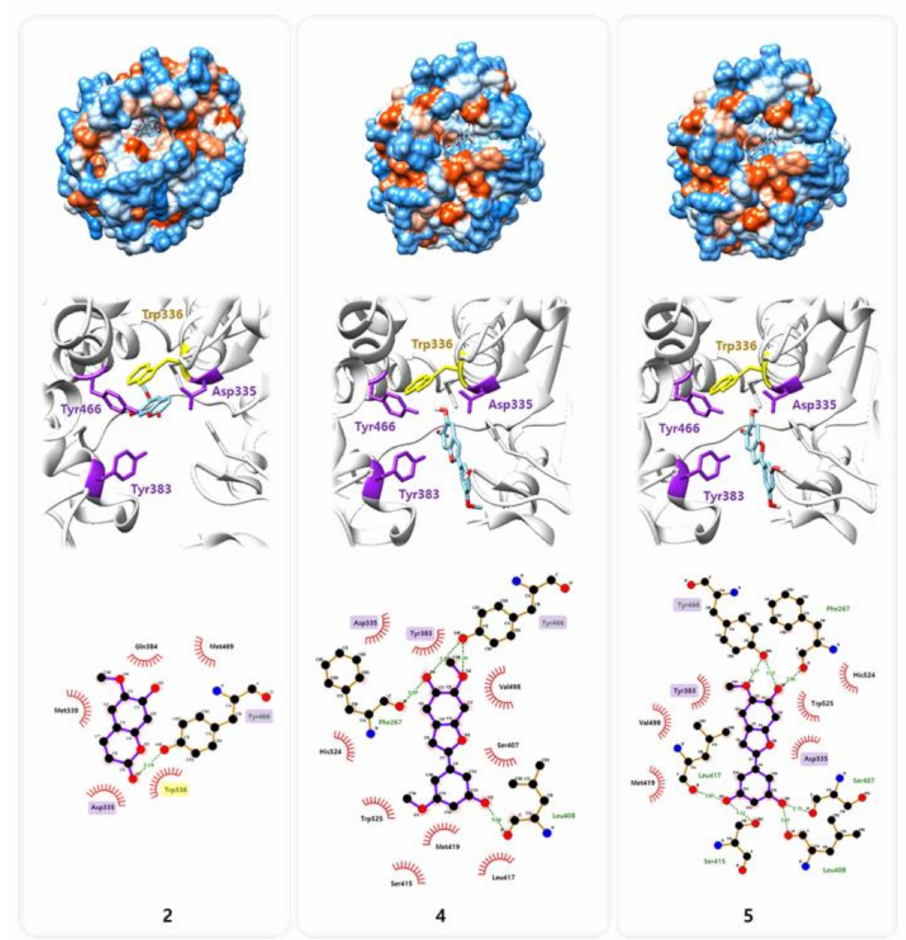
Figure 4. Molecular docking simulation of compounds 2 , 4 , and 5 into the predicted binding site of